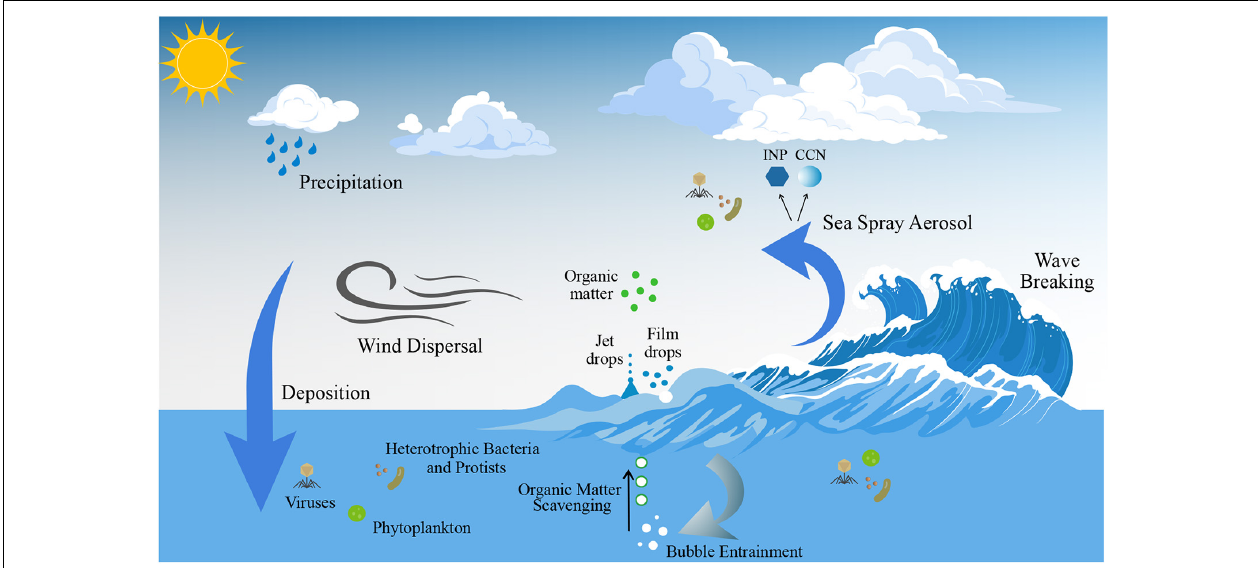
FIGURE 4 | Physical processes associated with the generation of sea spray aerosol (SSA). Breaking waves entrain air, which results in bubbles bursting at the air-sea interface, lofting jet and film drops into the atmosphere, which form SSA. A subset of SSA catalyzes cloud formation by acting as cloud condensation nuclei (CCN) or ice nucleating particles (INPs). Primary marine aerosol formation via sea spray results in the transfer of marine microorganisms and organic matter to the atmosphere, which are transported over the ocean and deposited in a new location via processes such as wet deposition. The vector art used in this figure was downloaded from